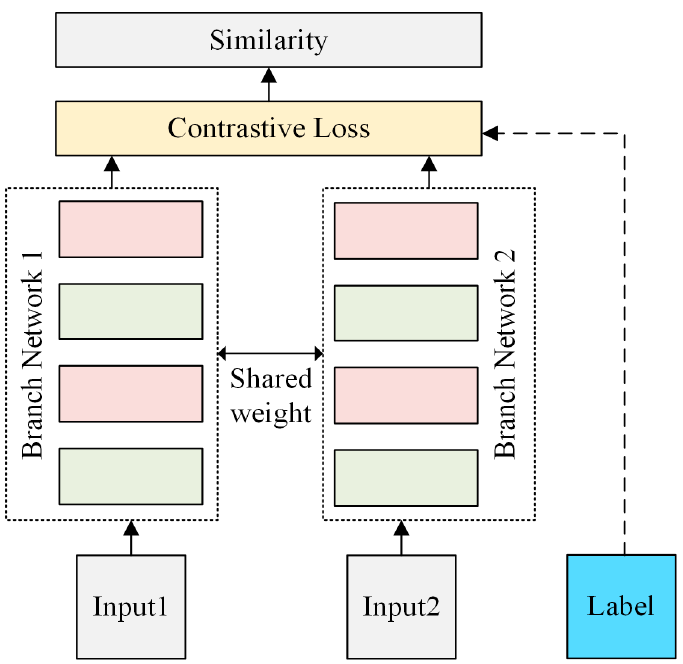
Figure 4. Illustration of a traditional Siamese network structure.